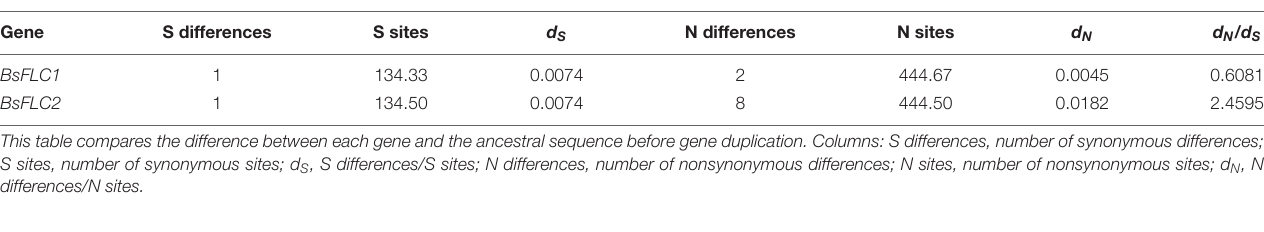
TABLE 3 | Synonymous and non-synonymous substitutions in BsFLC1 and BsFLC after gene duplication. Gene